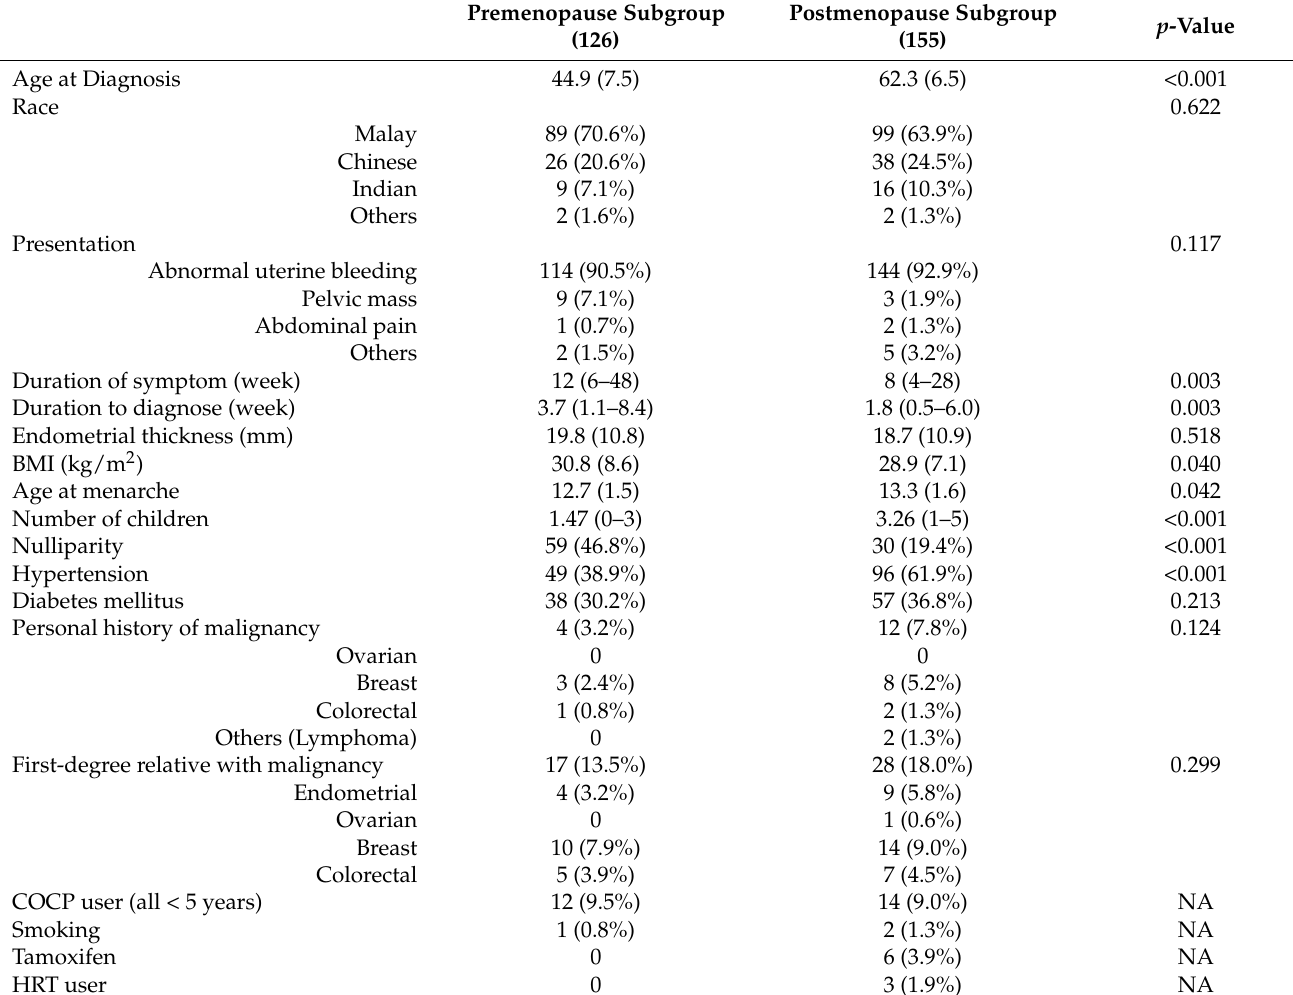
Table 1. Clinical characteristics of Endometrial Cancer